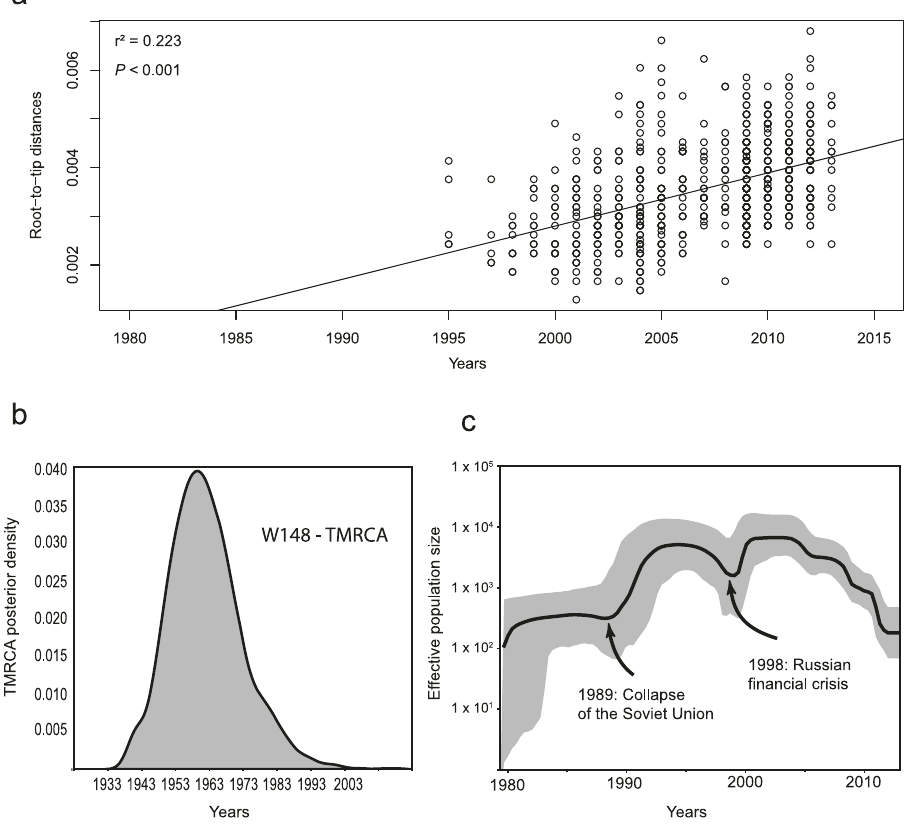
Fig. 2 | W148 is a measurably evolving population. a Linear regression analysis (leastsquareapproximation)showingcorrelationbetweenroot-to-tipdistanceand sampling years of the W148 strain collection ( n =720) covering the period 1995 – 2013. b Posterior density distribution of the W148 clade TMRCA. c Effective population size over time of the 720 W148 strains based on a Bayesian skyline